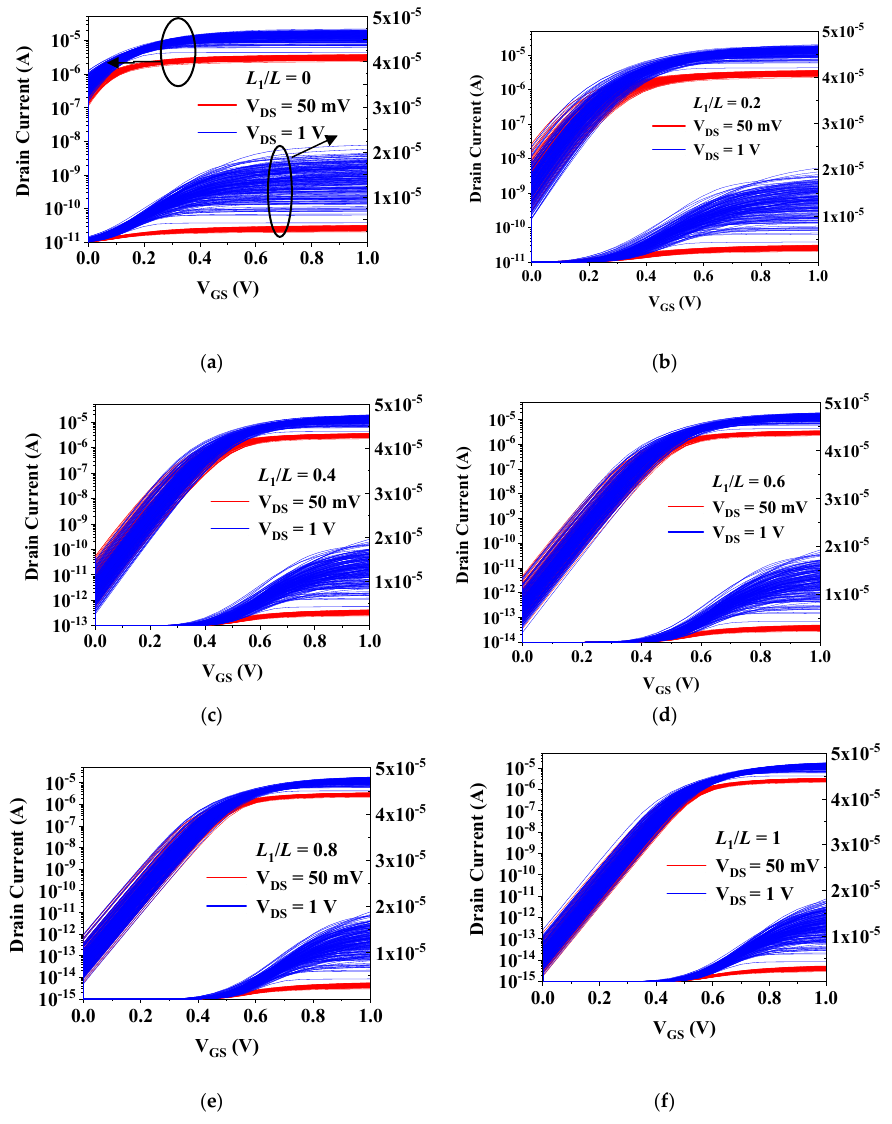
Figure 2. RDF-induced dispersions of drain current versus gate voltage (VGS) for DMG JL FinFET. (a) - (f) are transfer curves in L 1 / L from 0 to 1 in steps of 0.2. The frequency distribution of V TH for each L 1 / L at V DS = 0.05 V and 1 V is shown in Figure 3. The standard deviations ( σ ), average ( μ ), and coefficient ( σ / μ ) of variation of V TH for each case were also